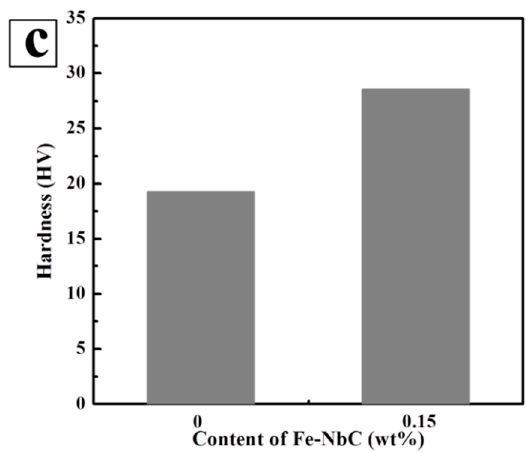
Figure 7. Representative optical micrographs of the cast steels with ( a ) 0 wt % NbC; ( b ) 0.15 wt % NbC in the form of NbC–Fe; and ( c ) hardness of the casted steels.